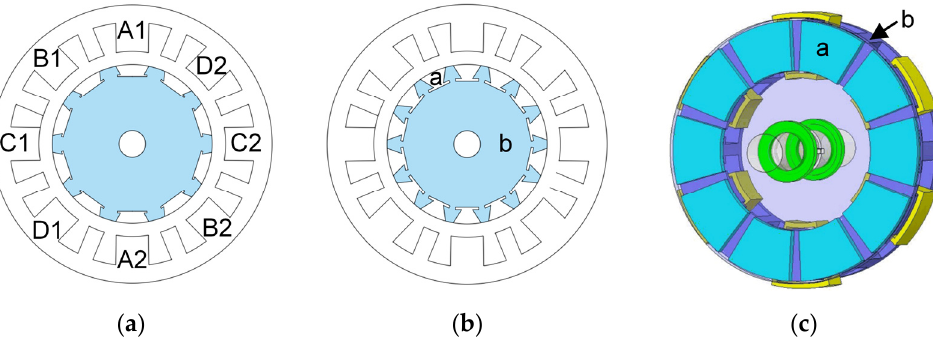
Figure 8. Proposed segmental rotor SRM with CW which used in a belt-driven generator of vehicles and 12/10 axial field SSRM. ( a ) is the structure of the 16/10 segmental rotor SRM; ( b ) is the structure of the 16/14 segmental rotor SRM where “a” depicts the segmented rotors and “b” is the non-magnetic isolator; ( c ) is the structure of the 12/10 segmental rotor AFSRM where “a” depicts the segmented rotors, “b” is stator core, and the yellow area is copper coils.